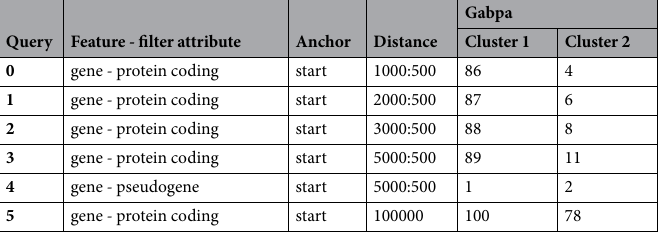
Table 2. Gabp-alpha associated, in silico predicted binding sites: Binding sites are clustered by ATAC-seq signal into open (c1) and closed (c2) regions. For each query indicated as rows, the percentage of peaks with